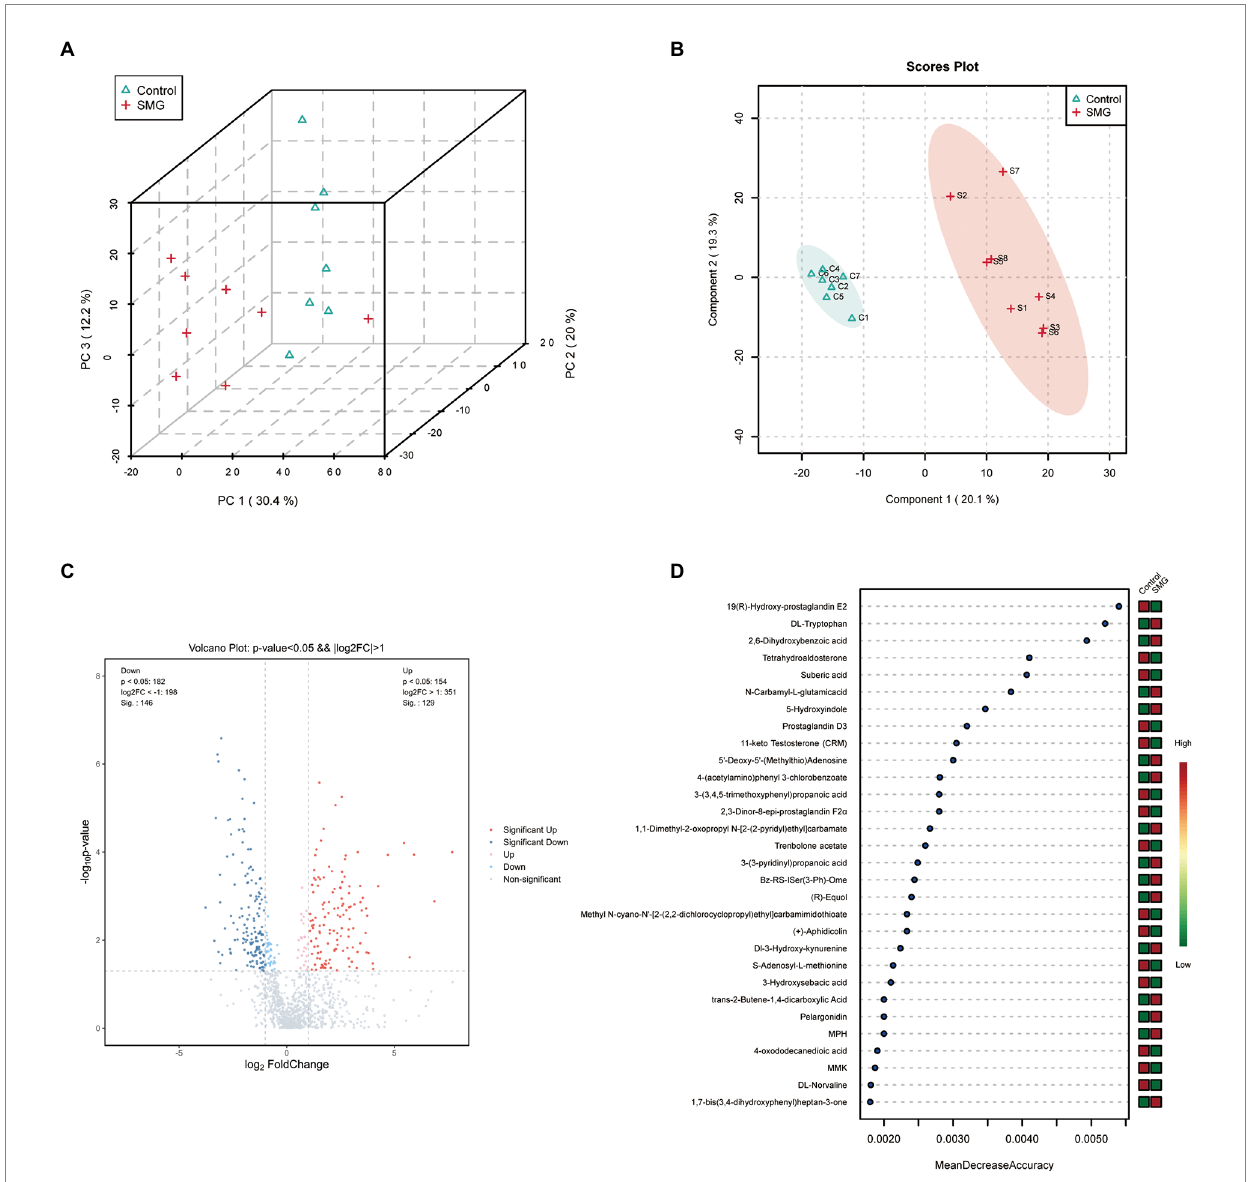
FIGURE 4 Long-term SMG alters intestinal metabolome profile. (A) PCA scores plots of intestinal metabolites based on the Bray–Curtis distance between SMG and control groups. (B) PLS-DA scores plots of intestinal metabolites between two groups. (C) Volcano plot of the differential metabolites between SMG and control groups. Each dot represents a specific metabolite. The red point means up-regulation, blue point means downregulation. (D) The top 30 named metabolites identified in random forests. The higher value of mean decrease accuracy, the higher the importance of the